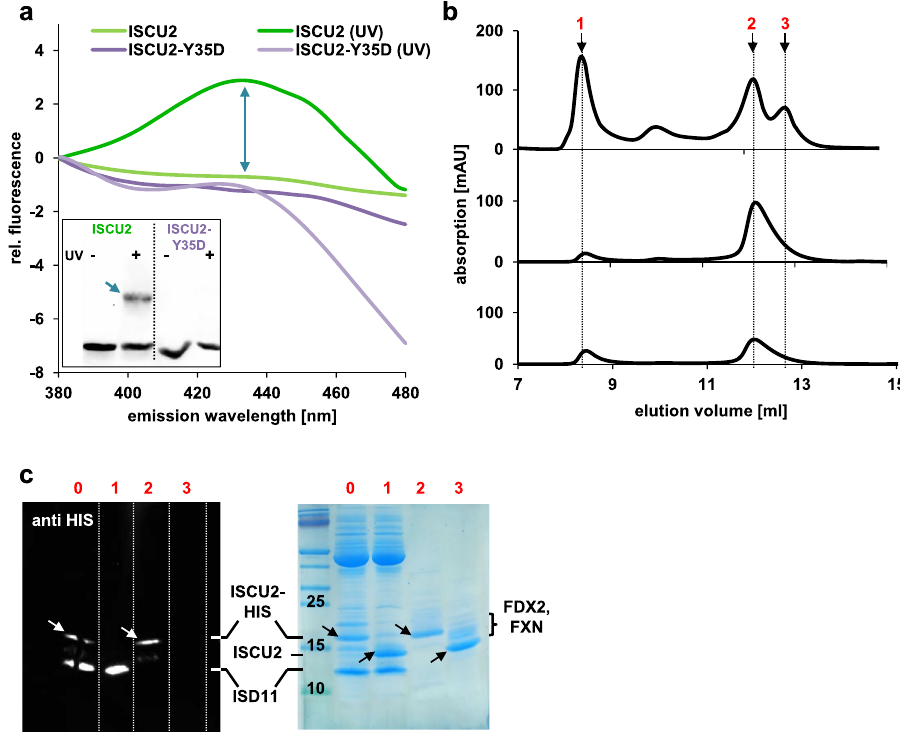
Fig. 6 Tyr35-Tyr35 interactions between two (NIA) 2 -bound ISCU2 are crucial for triggering [2Fe-2S] cluster formation by ISCU2 dimerization. a Di-tyrosine formation by UV-crosslinking. Chemically reconstituted ISCU2 but not ISCU2-Y35D (lacking N-terminal Tyr35, but having two other Tyr) show a fl uorescence increase (arrow) at λ Ex 320 nm and λ Em 380 – 460 nm upon UV irradiation characteristic for di-tyrosine formation. The spectra recorded before and after crosslinking are set to the values at λ Em 380 nm. The inset shows an immunoblot of a reducing SDS-PAGE from the UV-treated samples stained for the HIS-tag of the ISCU2 proteins. The band marked by the arrow represents the di-tyrosine-linked ISCU2 dimer. The experiment was repeated twice with similar outcome. b Only (NIA) 2 -bound ISCU2 and not free ISCU2 gives rise to holo-ISCU2 dimer formation. For experimental setup see Supplementary Fig. 10a. Representative aSEC pro fi les are shown for absorption at 280 nm (protein), 320 nm (Fe/S cluster) and 420 nm (Fe/S cluster and PLP). c Fractions from peaks 1 to 3 of part b containing (NIA) 2 , dimeric ISCU2-HIS and monomeric ISCU2, respectively, were analyzed by SDS-PAGE and subsequent anti-HIS tag immunostaining or Coomassie staining. The reaction mixture prior to Cys addition (sample 0) served as a control (cf. Supplementary Fig. 10a). The experiment was repeated twice with similar outcome. Source Data are provided as a Source Data fi